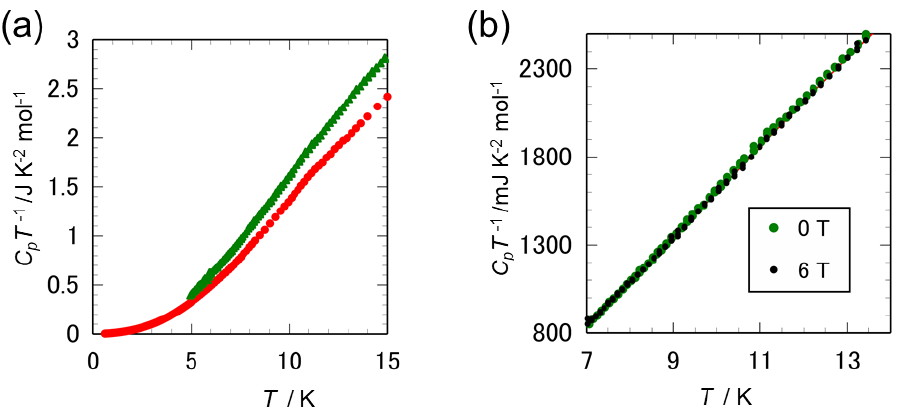
Figure 7. ( a ) C p T − 1 vs. T plot of the heat capacity of the d[0,0] compound (red color) and that of the d[3,3] compound (green color) obtained at 0 T; ( b ) the extended plot around the superconducting transition of the d[3,3] compound obtained at 0 T and 6 T. The data at magnetic fields of 0 T and 6 T are shown by the green circles and the black circles, respectively. A broad and small hump around the transition seemed to be suppressed by an external magnetic field.